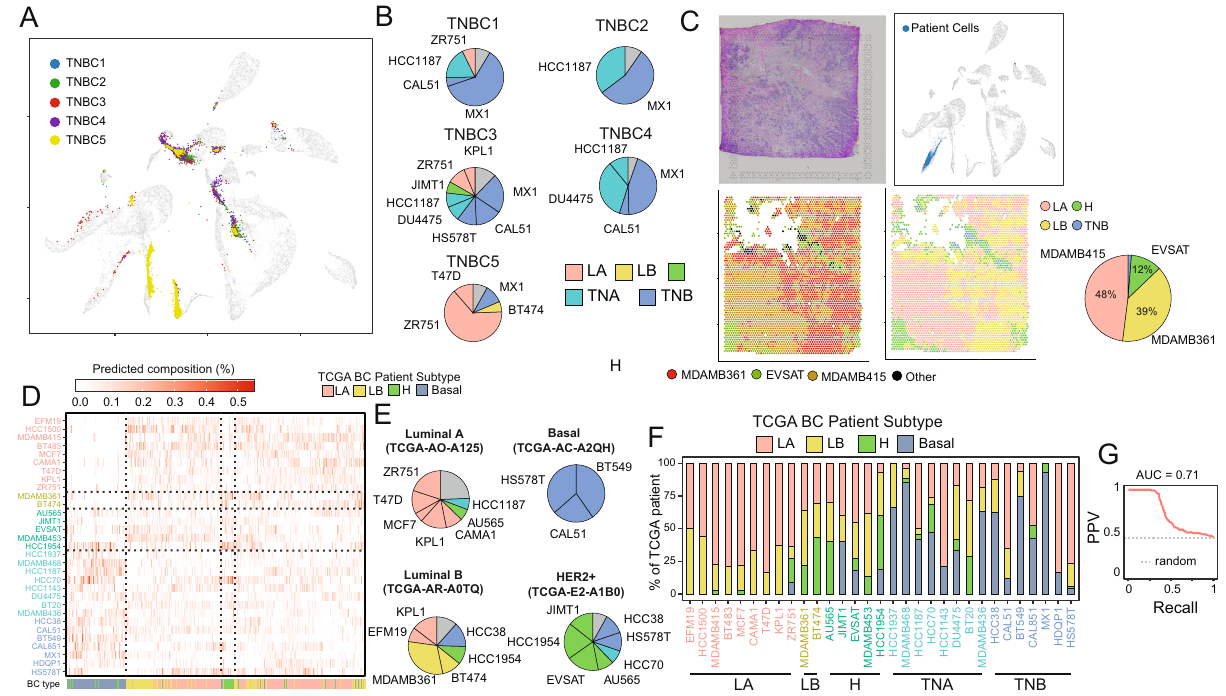
Fig. 2 Automatic classi fi cation of patients ’ tumour cells. A Cancer cells from triple-negative breast cancer (TNBC) biopsies of fi ve patients were embedded in the BC atlas by means of the mapping algorithm in order to predict their tumour subtype. B For each patient, the pie chart shows cell-line composition obtained by mapping patient ’ s cells onto the atlas. C Tissue-slide of an oestrogen-positive breast tumour biopsy sequenced by means of the 10× Genomics Visium spatial transcriptomics (top-left) and the position of the mapped tissue tiles onto the atlas (top-left). Tiles are colour-coded according to the cell line (bottom-left) and to tumour subtype (bottom-right) as predicted by the mapping algorithm. D Cell-line composition of 937 BC patients from the TGCA database as estimated by the Bisque algorithm from their bulk RNA-seq data. For ease of interpretation, in the heatmap patients are clustered according to their cell-line composition. The bottom row reports the annotated cancer subtype in TGCA. E Predicted cell-line composition by the Bisque algorithm for four representative patients. F The distribution of the 937 BC patients across the 32 cell lines. For each cell line, the stacked bars report the percentage of patients of a given cancer subtype assigned by Bisque to that cell line. Since each patient is usually predicted by Bisque to be composed by multiple cell lines, the patient is associated to the cell line making up the largest fraction of the patient ’ s cell-line composition. G Performance of Bisque in classifying the tumour subtype of the 937 BC patients in TGCA from bulk gene expression pro fi les. Since each patient is usually predicted by Bisque to be composed by multiple cell lines, the patient is associated to the tumour type of the cell line making up the largest fraction of the cell-line composition. (PPV positive predictive value, AUC area under the curve). Source data are provided in a Source data fi